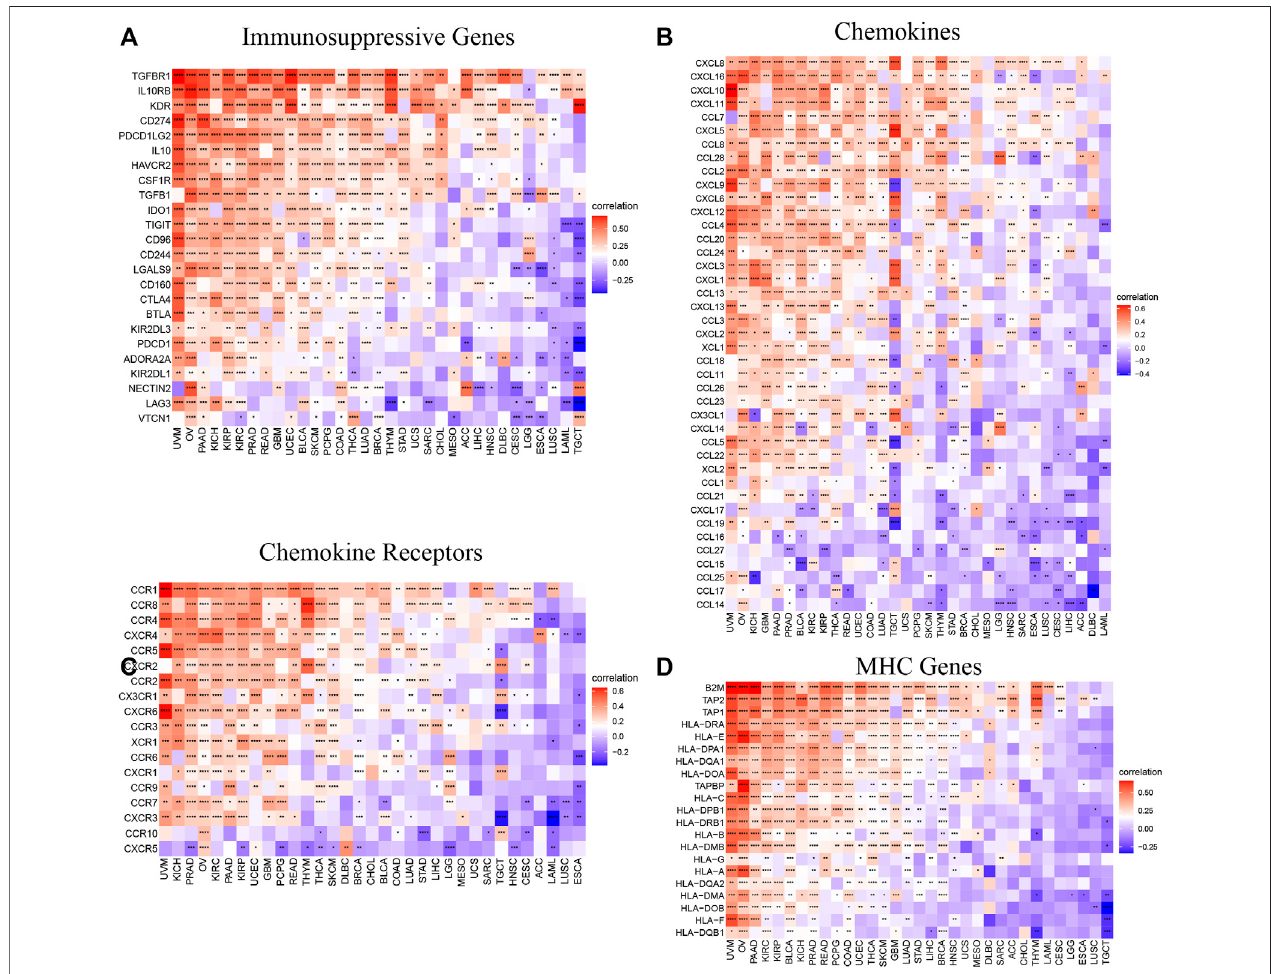
FIGURE 10 | Relationship between AP3S1 expression and that of immune-related genes. (A) Immunosuppressive genes. (B) Chemokines. (D) Chemokine receptors. (C) MHC genes. Red represents positive correlation, blue represents negative correlation, and the darker the color, the stronger the correlation. * p < 0.05, ** p < 0.01, *** p <